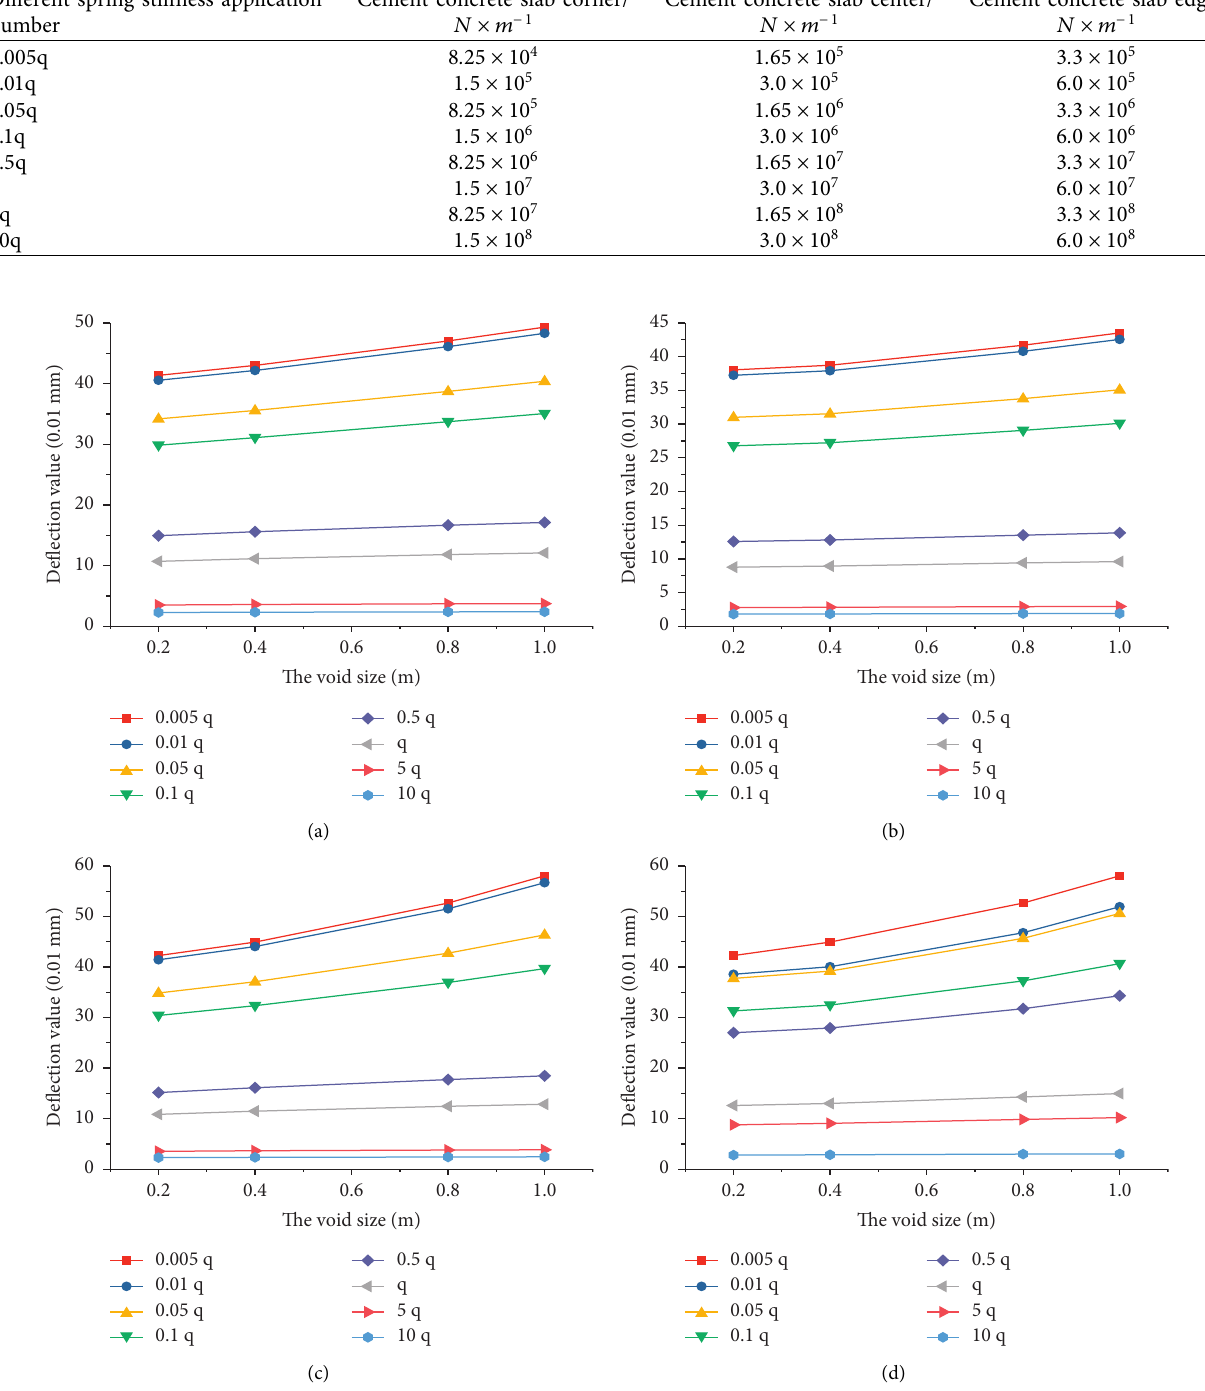
Figure 13: Slab deflection under different values of spring stiffness and degree of void: (a) deflection of loaded slab with semivoid state, (b) deflection of nonloaded slab with semivoid state, (c) deflection of loaded slab with full void state, and (d) deflection of nonloaded slab with full void state.